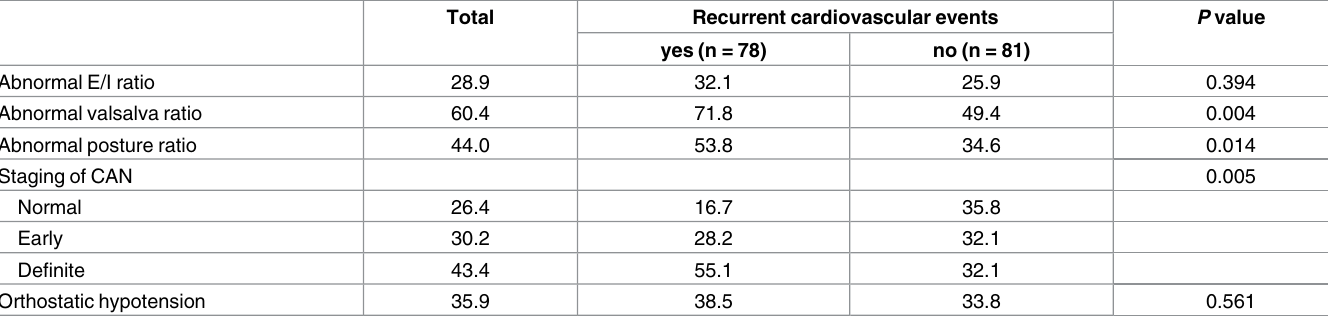
Table 2. Cardiovascular autonomic neuropathy and recurrent cardiovascular